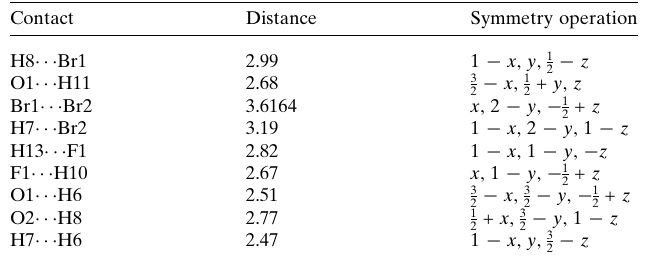
Table 3 Percentage contributions of interatomic contacts to the Hirshfeld surface for the title salt.